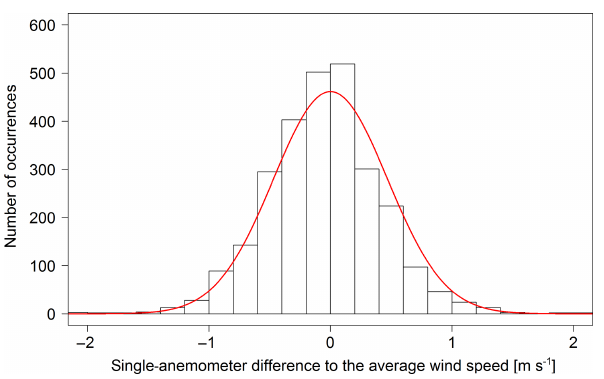
Figure 8. Estimation of uncertainty of the artificial wind speed. Histogram of the wind speed difference between a single anemome- ter and the average wind speed of all free-flow anemometers. The displayed Gaussian distribution (red line) has the standard devia- tion of 0.46ms − 1 . A sector of 30 ◦ centering full-wake alignment has been